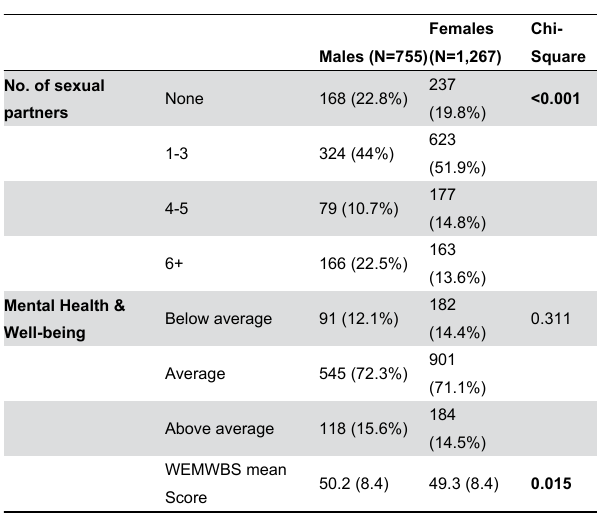
Table 1. Characteristics of students sociodemographic factors and WEMWBS scores by gender [N (%)/Mean